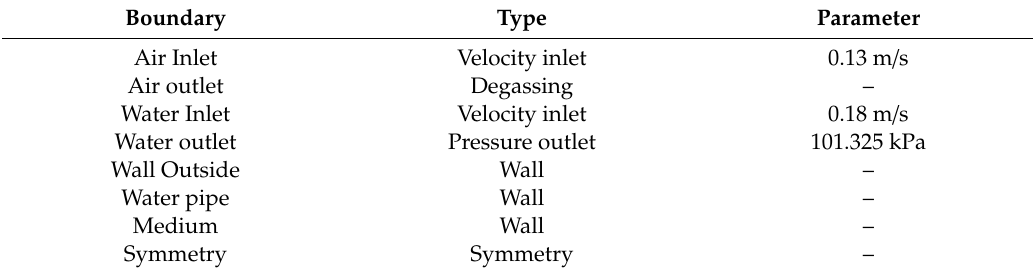
Table 2. Boundary conditions of the simulation